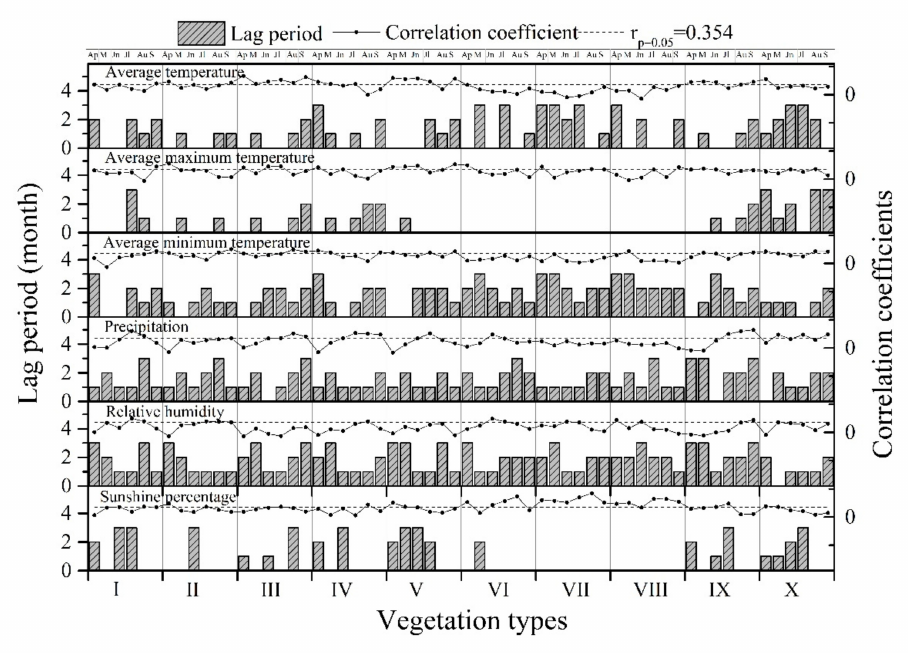
Figure 8. Correlation coefficient and lag time for each vegetation type during the growing season (i.e., from April to September). The dash lines are at the statistical significance of 0.05. ( I ) Alpine steppe, ( II ) Alpine meadow, ( III ) Alpine desert, ( IV ) Temperate desert steppe, ( V ) Alpine sparse vegetation, ( VI ) Subalpine scrub, ( VII ) Needleleaf forest, ( VIII ) Broadleaf evergreen forest, ( IX ) Temperate desert, ( X ) Temperate